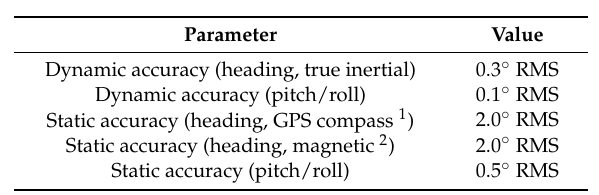
the VN-300. GPS, Global Positioning System. Table 1. Manufacturer-specified dynamic and static accuracies (RMS) in the yaw, pitch, and roll of